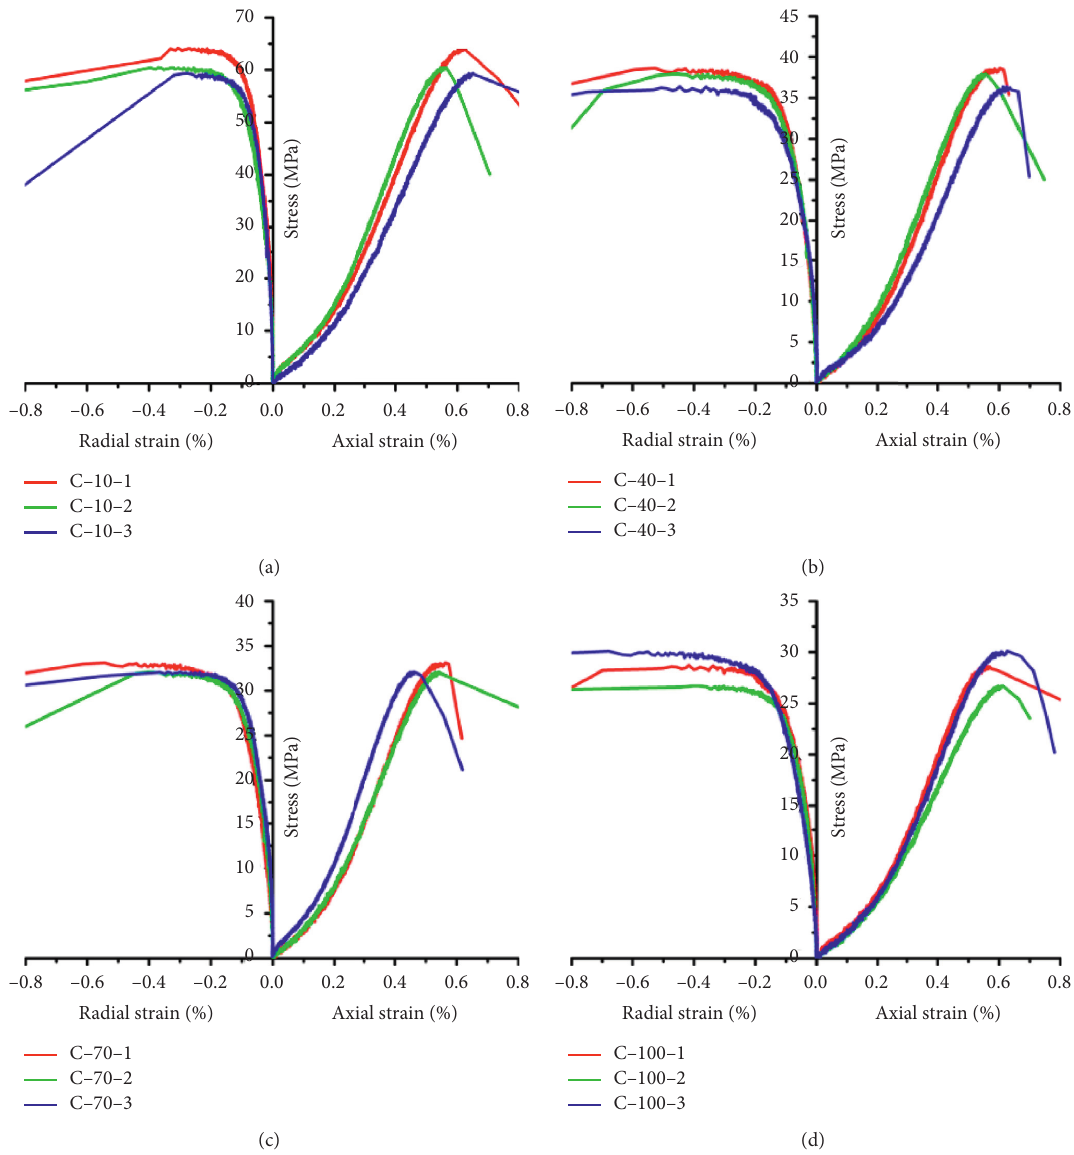
Figure 5: Complete stress-strain curves of sandstone samples with different water content rates. (a) C-10 rock group in the natural state. (b) C-40 rock group with 2.0% water content rate. (c) C-70 rock group with 3.5% water content rate. (d) C-100 rock group in the saturated